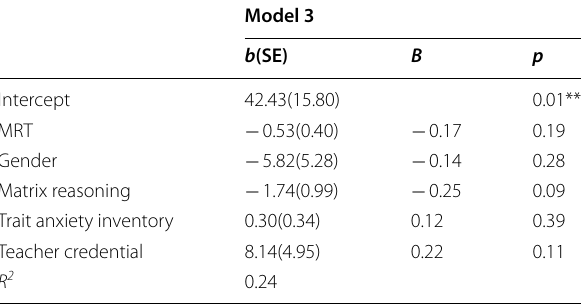
B are standardized betas. Numbers in parentheses are standard errors. The outcome variable for Model 3 was teachers’ Spatial Anxiety Scale score * p < 0.05, ** p < 0.01